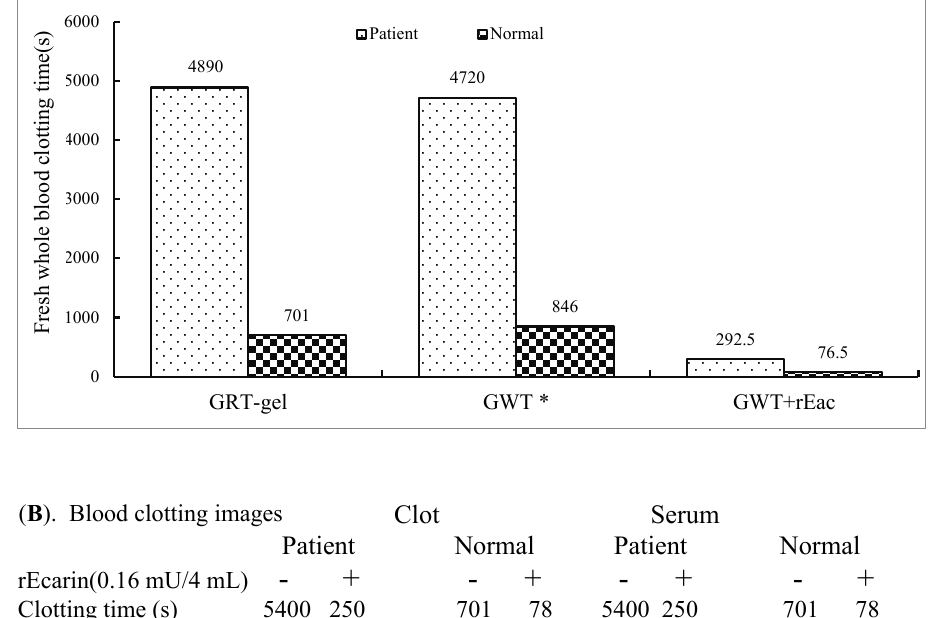
Figure 5. rEcarin clots effectively blood from one patient on Dabigatran therapy 780